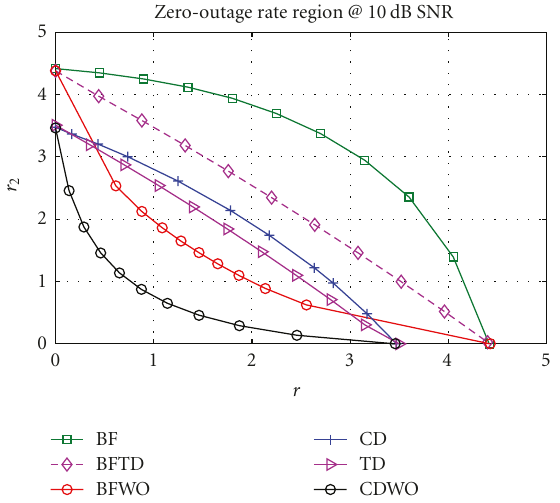
Figure 7: Zero-outage capacity region (CDWO) for MISO BC with two transmit antennas and two users for di ff erent correlation scenarios λ = 1 and λ = 1 .